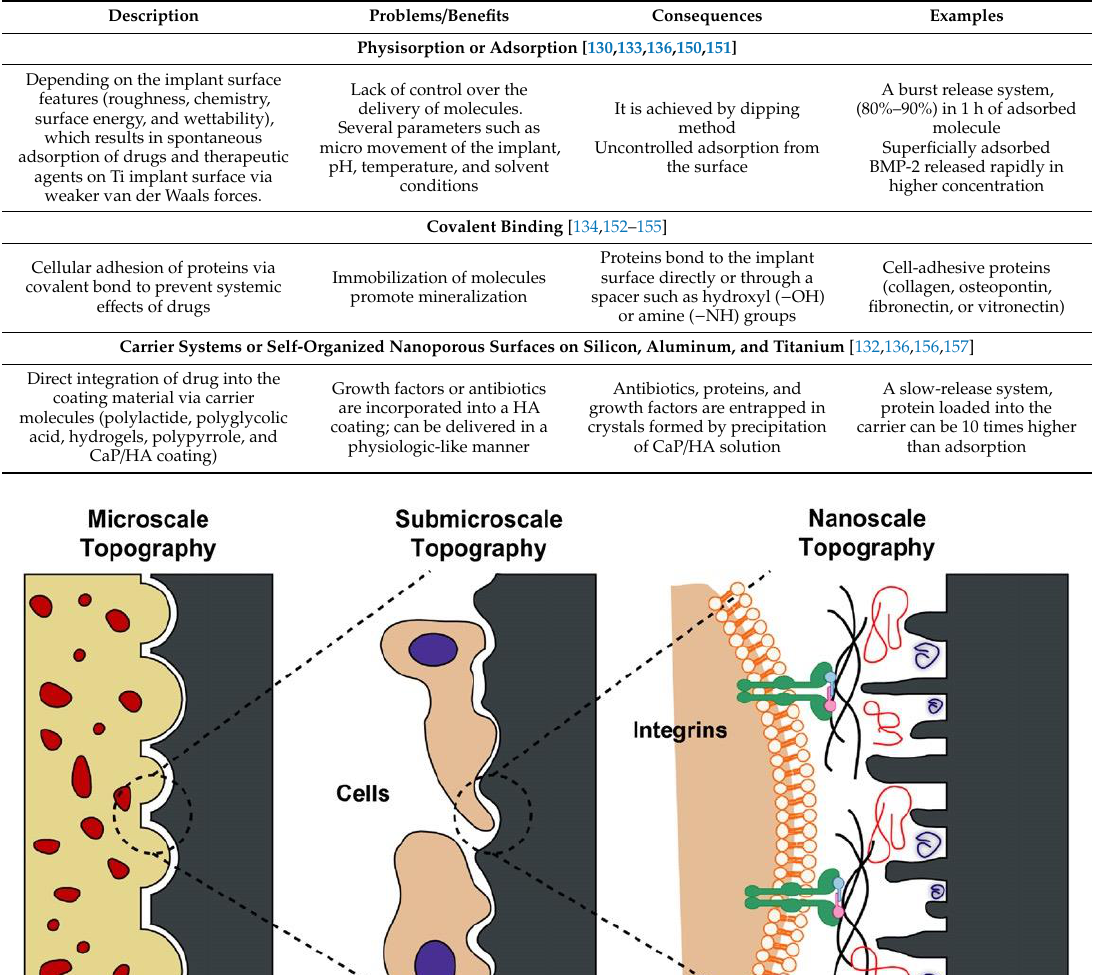
Table 1. Methods of biochemical modification and immobilization approaches for bioactive molecules on dental implant surface.